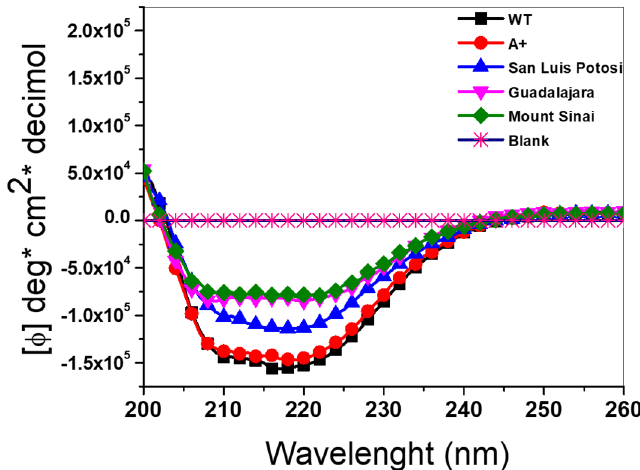
Figure 6. Circular dichroism (DC) spectra of four recombinant variants of human G6PD. Structural characterization was performed in the far UV region (200–260 nm). The experiment was conducted in triplicate.